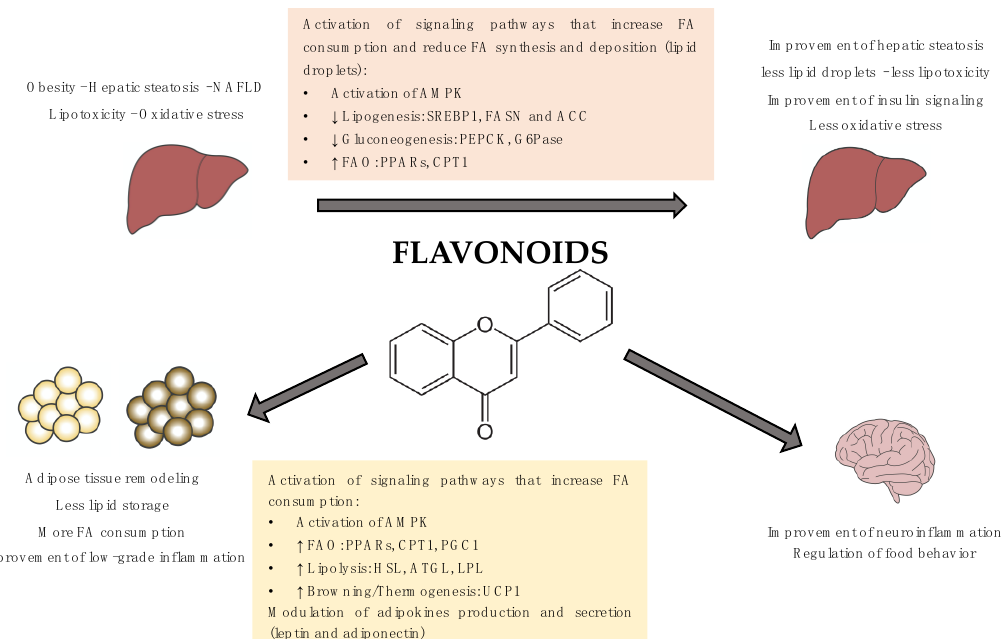
Figure 1. Summary of the metabolic and signaling pathways underlying the anti-obesity effects of flavonoids. Molecular mechanisms underlying the beneficial effects of flavonoids have been widely studied and, in many cases, involved the activation of the AMP-activated protein kinase (AMPK). AMPK is a key enzyme for the control of lipid metabolism and adipogenesis. AMPK phosphorylation and activation promote catabolic processes such as FAO, glucose uptake, or glycolysis as well as inhibits anabolic pathways such as fatty acid synthesis or gluconeogenesis.